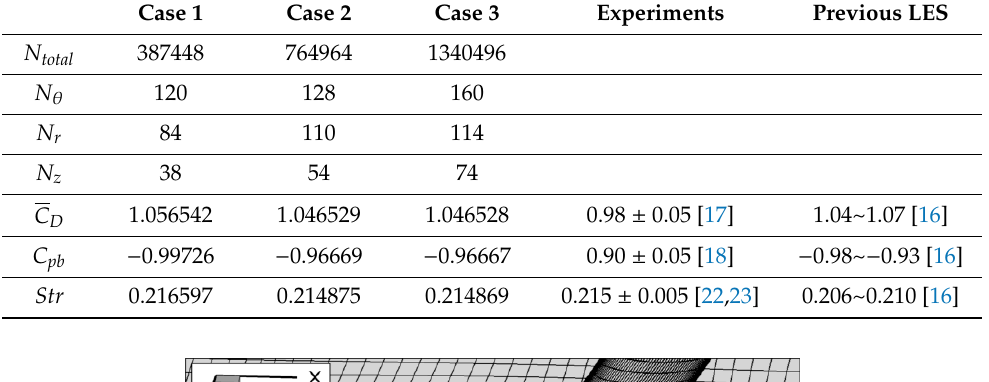
Table 1. Mesh independence check for a single circular cylinder at θ = 0 ◦ and Re = 3900.